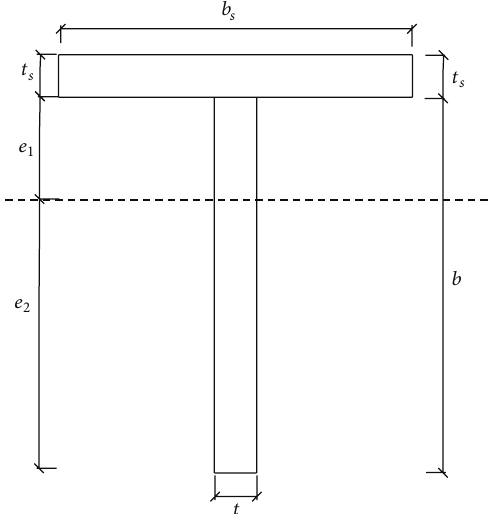
Figure 9: Schematic drawing of edge stiffener.